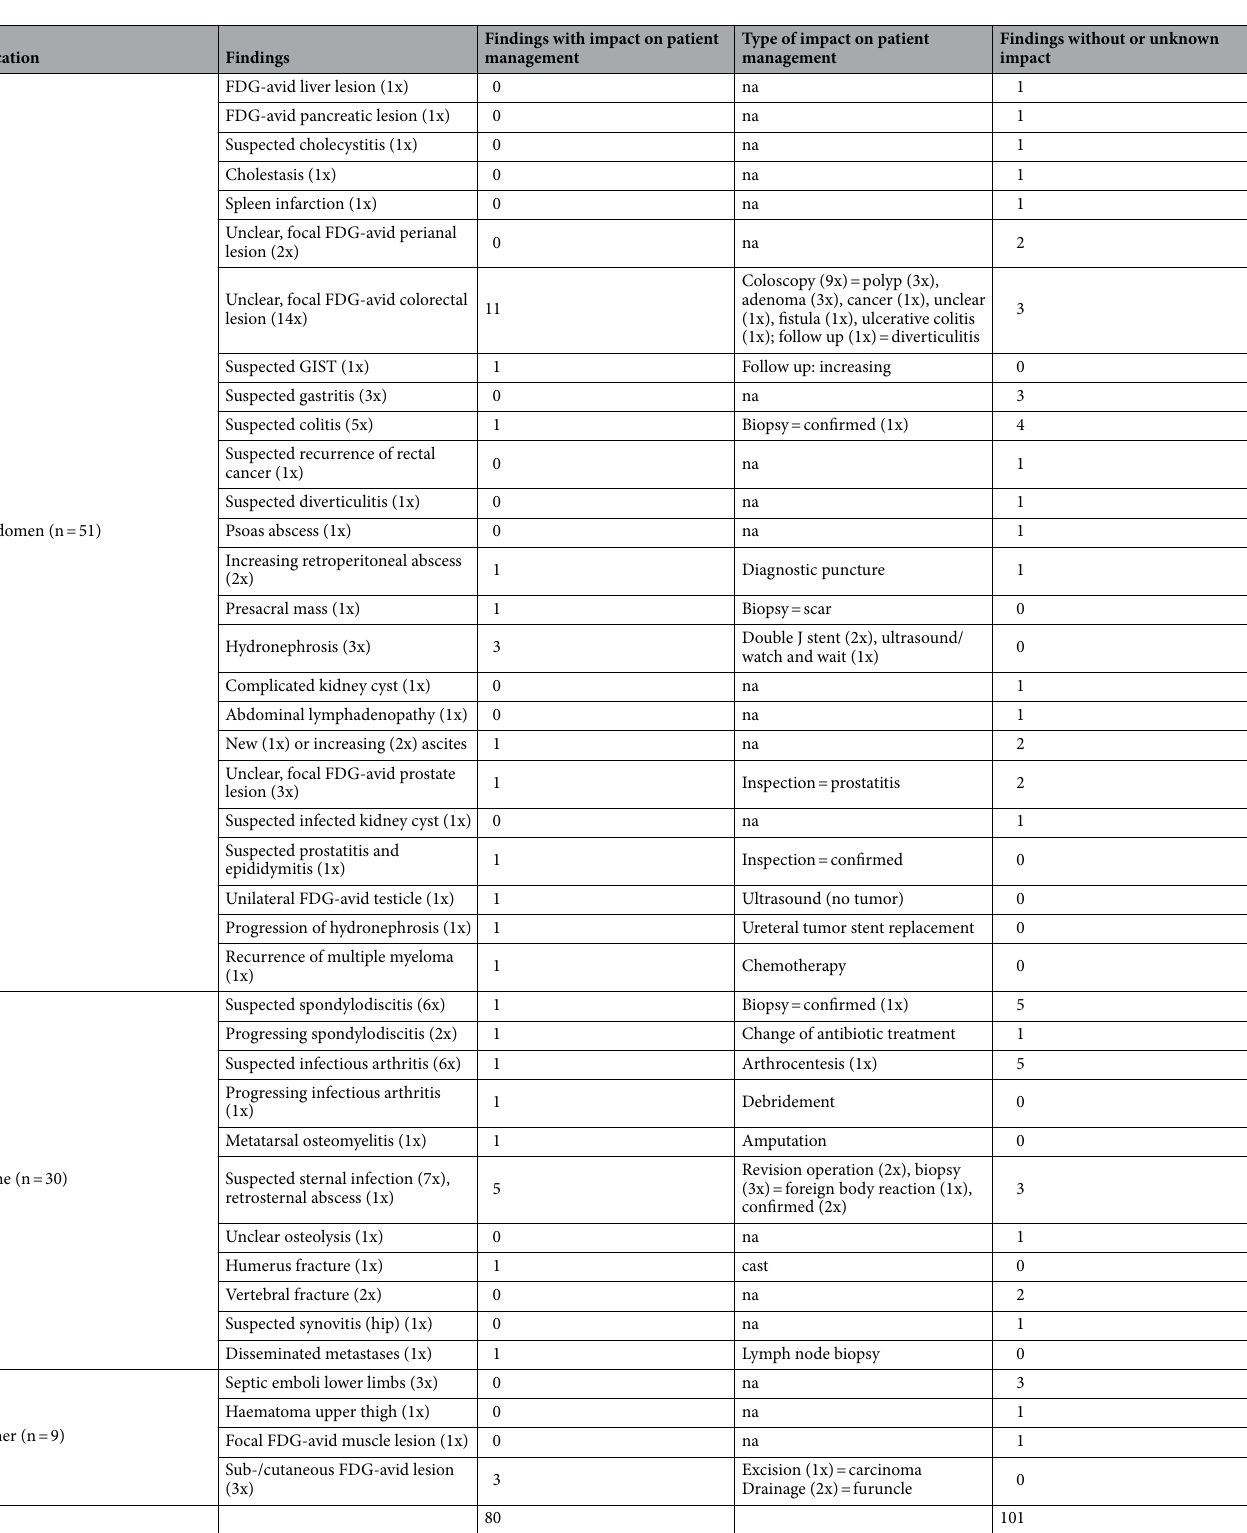
Table 2. Unknown and relevant incidental findings in 502 PET/CT scans of 162 patients with proven or suspected vascular graft infections and their impact on patient management. Na not applicable,